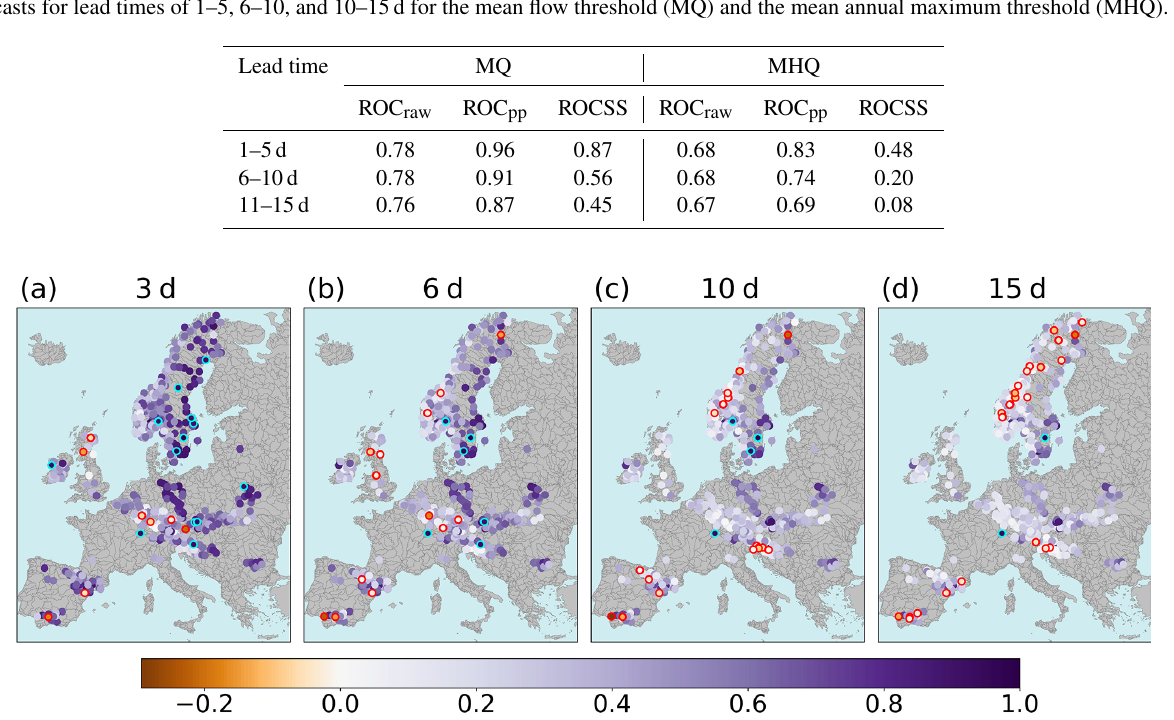
Table 1. Relative operating characteristic scores (ROCS) and corresponding skill scores (ROCSS) for the raw and post-processed (pp) forecasts for lead times of 1–5, 6–10, and 10–15d for the mean flow threshold (MQ) and the mean annual maximum threshold (MHQ).